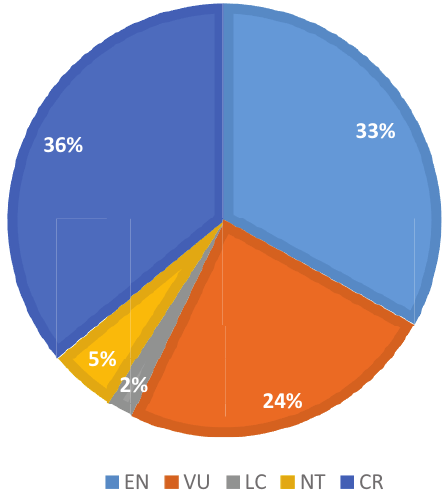
Figure 26. Percent distribution of rheophytes of Cameroon according to IUCN Red List Categories (CR- Critically Endangered; EN- Endangered; LC- Least Concern; NT- Near Threatened; and VU-